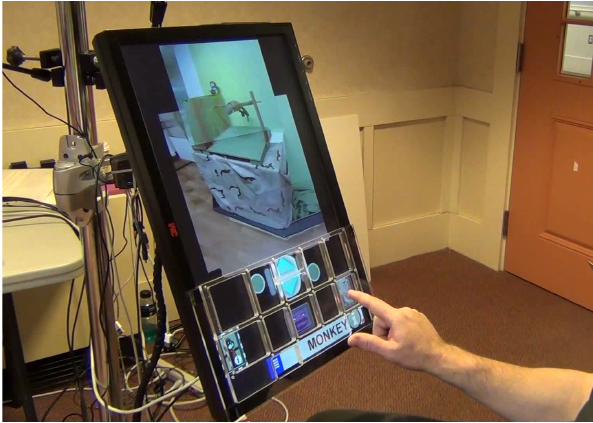
Fig. 7. A custom clear acrylic keyguard is shown over the lower third of the interface with cutouts for the exhibit buttons, step buttons, area around the robot base icon, menu button, and iButton. The 22” monitor (shown with keyguard) was mounted on an Ergotron cart with an adjustable swing arm, which allowed it to be placed in a manner that was comfortable for the user to see and